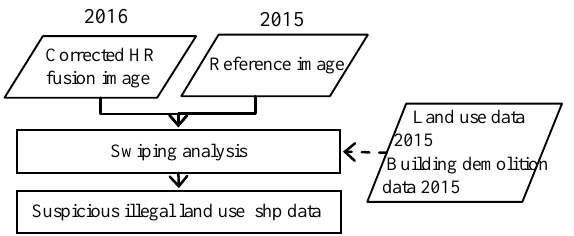
Figure 2. Suspicious illegal land use spots extraction